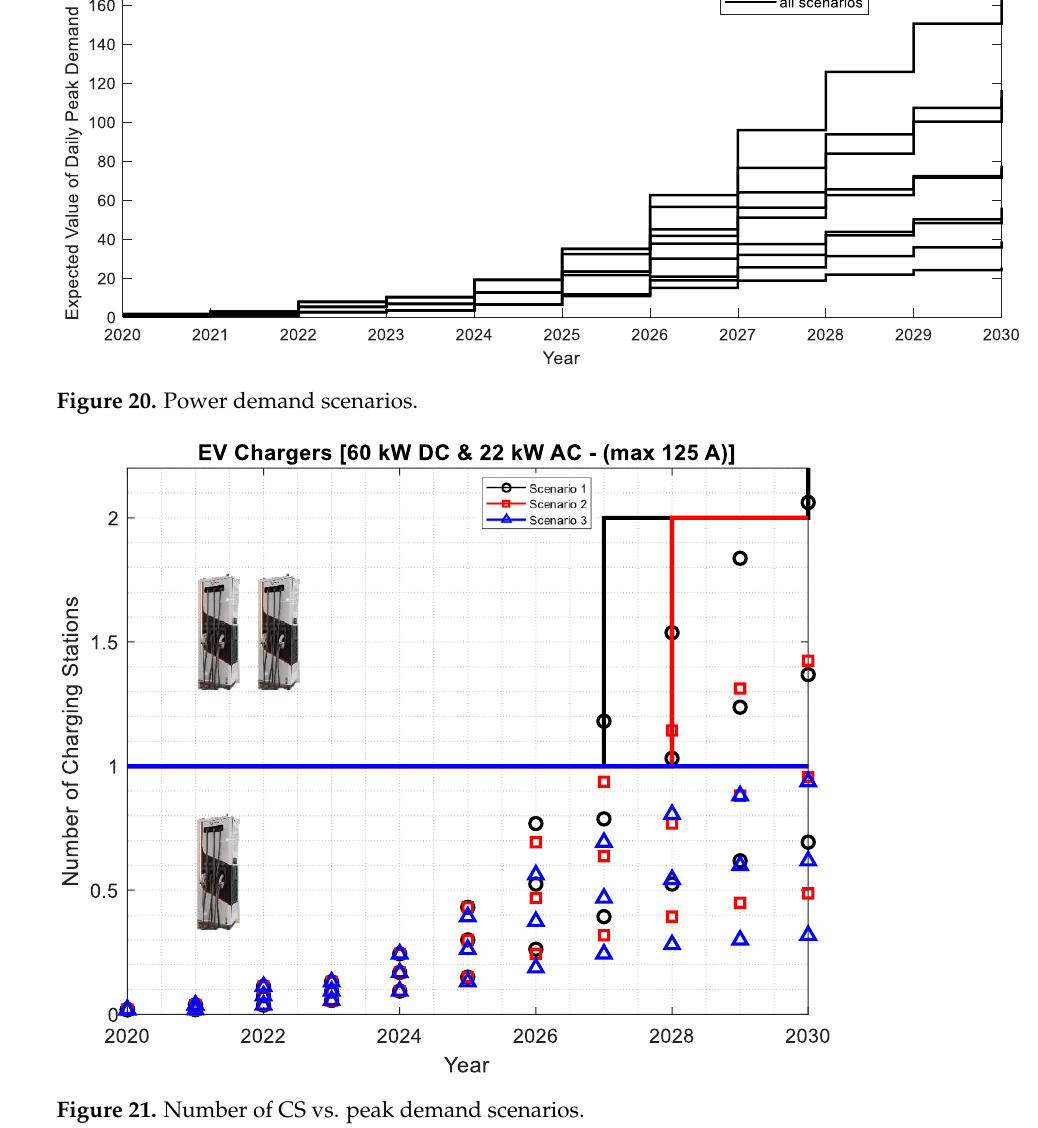
Figure 21. Number of CS vs. peak demand scenarios.